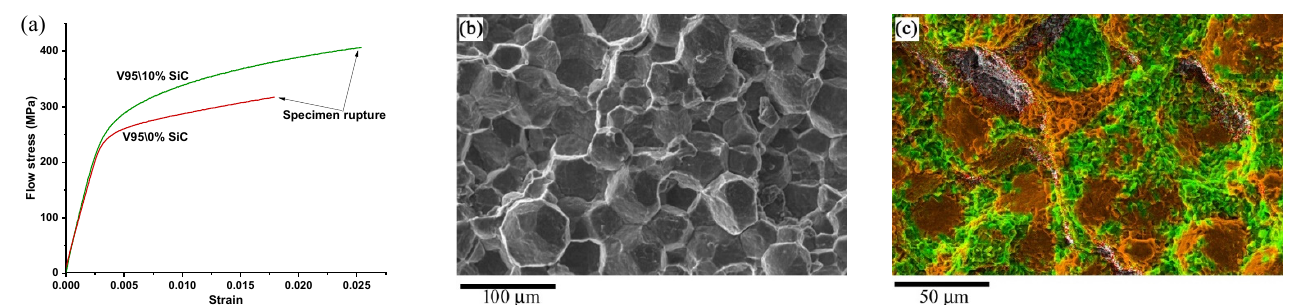
Figure 4. The strain dependence of flow stress under tension at room temperature ( a ); the fracture surface after the tension of the V95\0% SiC sintered material ( b ) and the V95\10% SiC metal matrix composite ( c ): orange—the matrix; green—SiC particles.